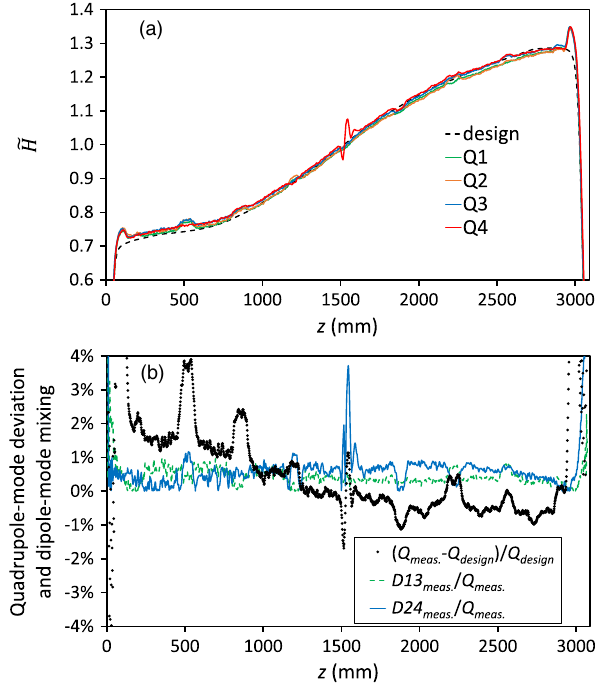
FIG. 15. (a) The measured H profile for all quadrants. The dashed line is the target profile as obtained in Sec. II. (b) The quadrupole-mode deviation and the dipole-mode mixing were derived from the measured magnetic